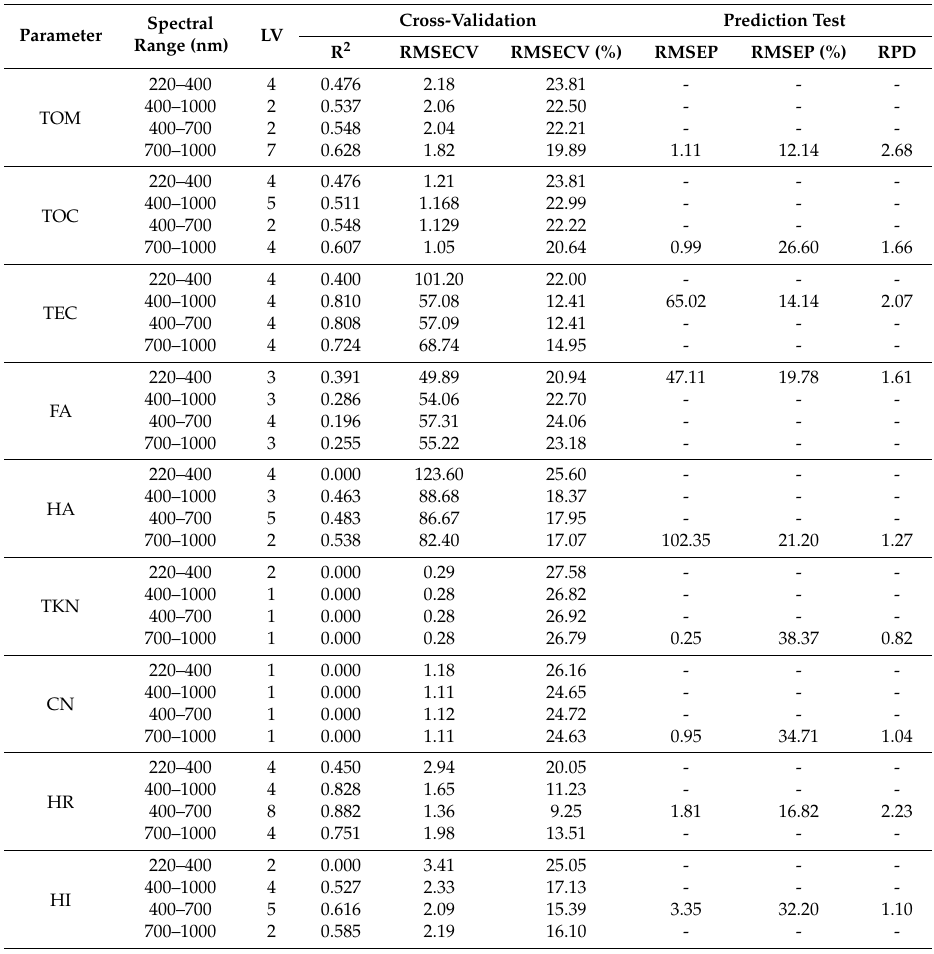
Table 2. Results of the partial least square regression (PLSR) cross-validation (CV) and prediction (P) models of compost analytical parameters and humification